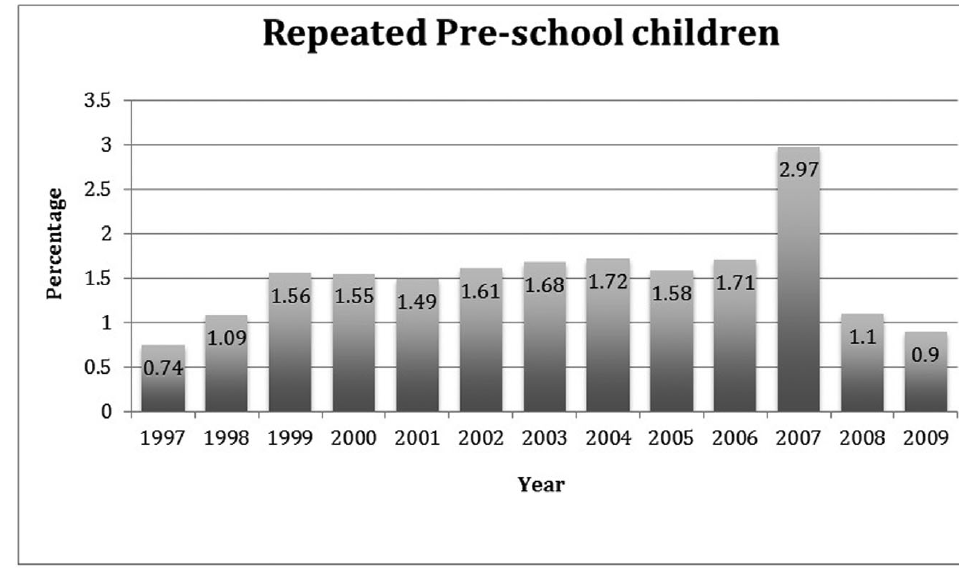
Percentage of students aged 5 years repeated in Queensland state schools 1997–2009 (DET, 2011).